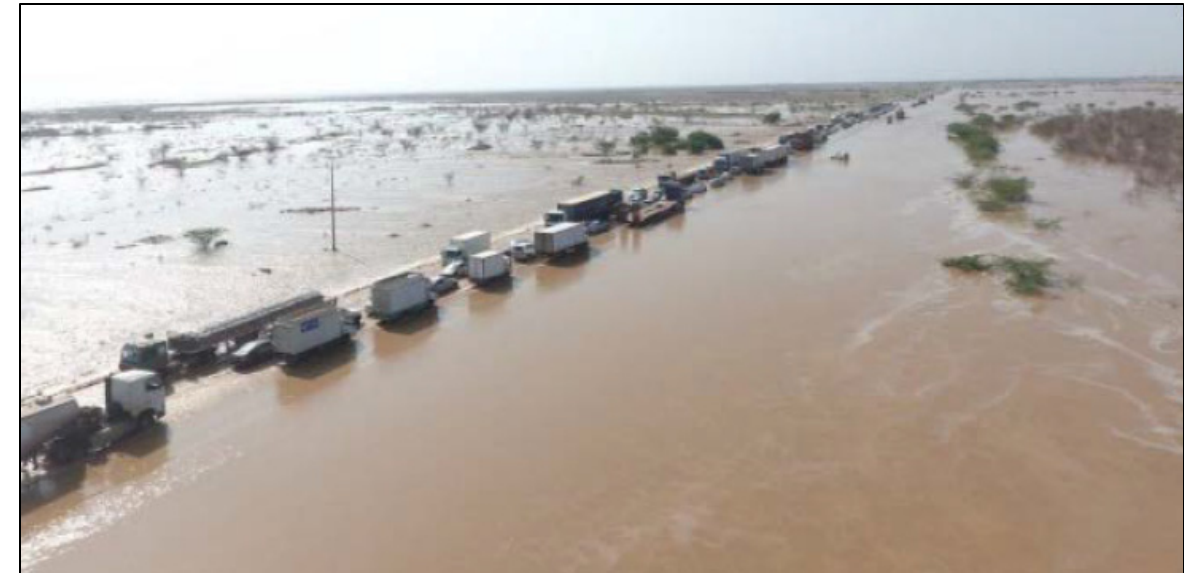
Figure 2. International Jizan–Jeddah road under the flooding of the Wadi Al-Lith [29].